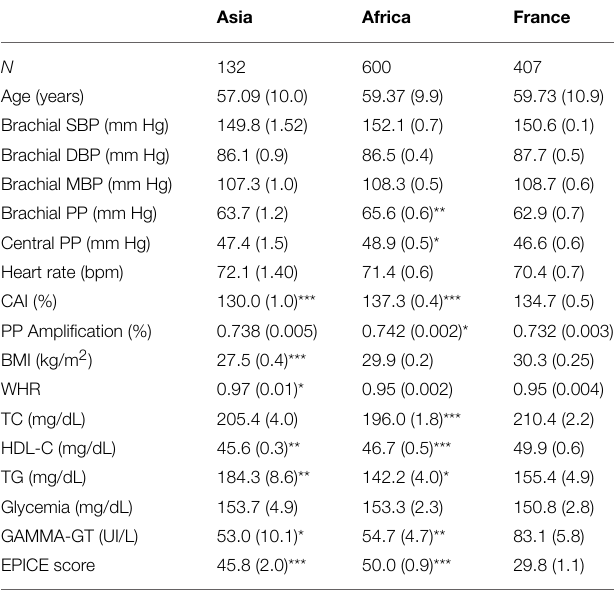
TABLE 4 | Main characteristics (with standard deviation) of individuals with hypertension and diabetes (men and women), according to country of